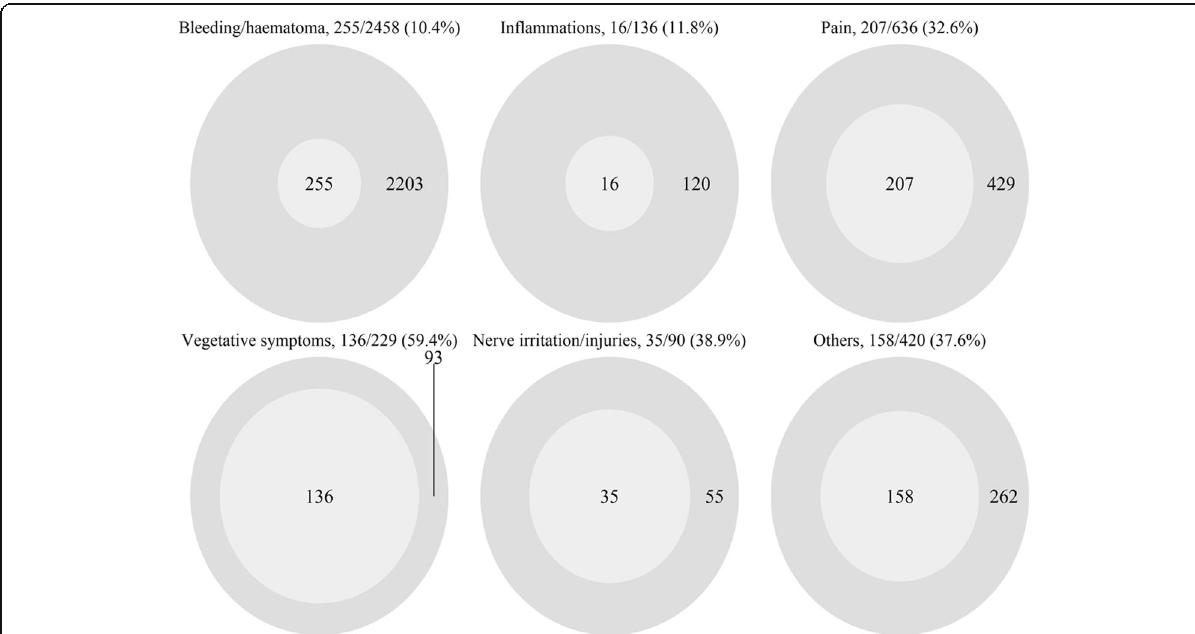
Fig. 1 Physicians (light grey inner circle) to patients (outer circle) reported adverse reactions in six categories: bleeding/haematoma ( n = 255 physicians and n = 2458 patients reports, the ratio represents 10.4%), inflammation, pain, vegetative symptoms, nerve irritation/injuries, and